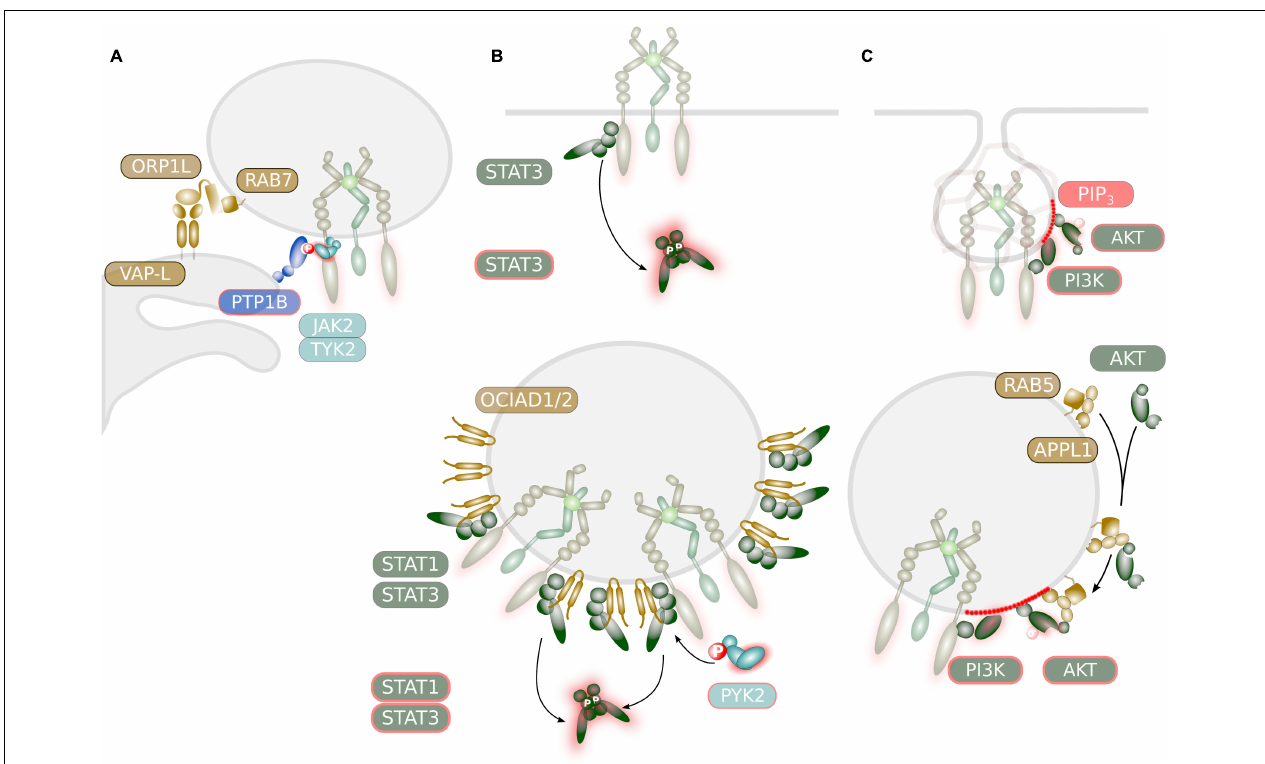
FIGURE 4 | Potential mechanisms regulating signaling of IL-6 family cytokine receptors at endosomes. (A) ER-contact sites might regulate JAK activity. The ER-resident PTPase PTPN1/PTP1B was demonstrated to deactivate STAT signaling through dephosphorylation of JAK2 or TYK2. This might occur at ER-endosome contact sites as was demonstrated for the EGFR. These contact sites are mediated via interaction of the integral ER protein VAP-L and the endosomal associated protein ORP1L which is a RAB7 effector. (B) Selective and sustainable STAT activation at endosomal membranes. STAT proteins with high receptor affinity are readily activated at the plasma membrane. Activation of lower affinity STAT proteins might depend on endosomal localization of the receptor. STAT activation by IL-6 family cytokines at endosomes might be facilitated by the endosome-associated protein OCIAD1/ASRIJ and OCAID2. Recruitment of PYK2 to endosomes might prolong STAT activation as was demonstrated for the EGFR and HGFR/MET. (C) Compartment-specific AKT activation. The generation of PIP 3 occurs in two waves: a first short peak at the plasma membrane and a second peak during clathrin-mediated endocytosis. Recruitment of PI3K isoforms to endosomes is mediated via RAB5. Activation of AKT by IL-6 family cytokine might be facilitated by the endosome-associated adaptor protein APPL1 that helps to recruit inactive